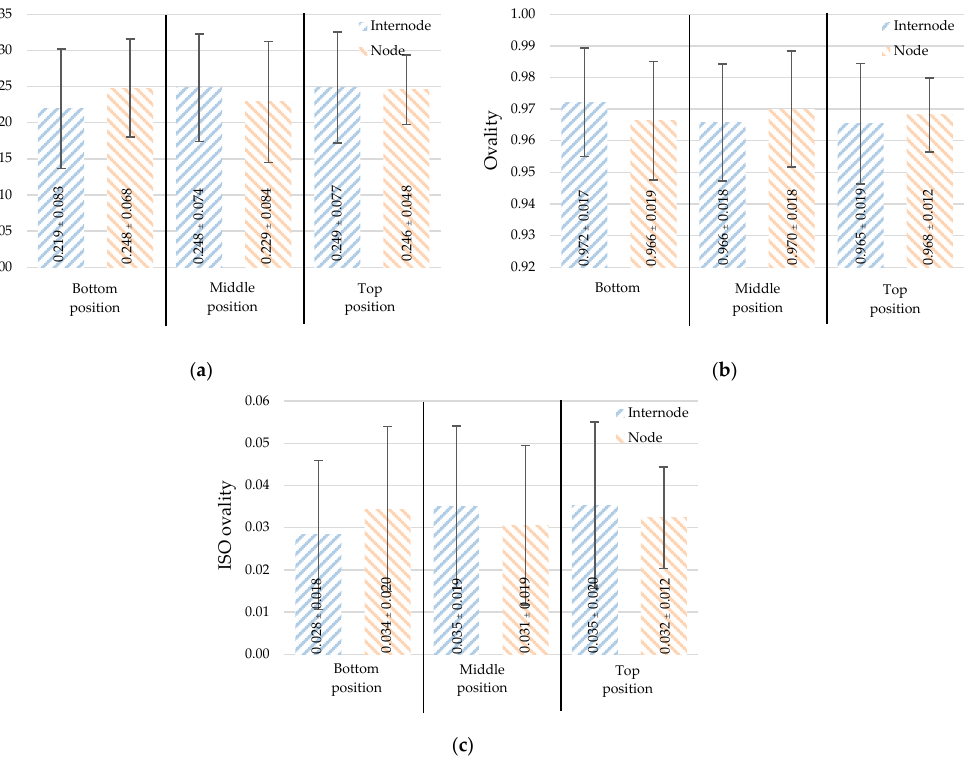
Figure 9. The cross-section integrity: ( a ) eccentricity, ( b ) ovality, and ( c ) ISO ovality (mean ± stand- ard deviation).